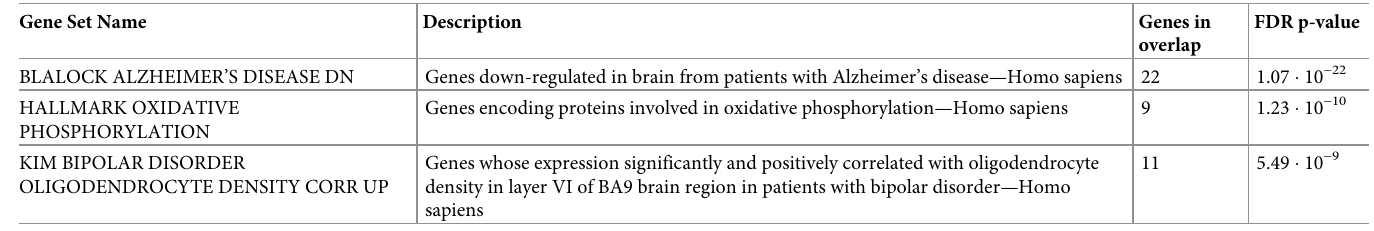
Table 3. Results of gene set enrichment analysis for C 2 community. In the third column the genes in the overlapping gene sets are reported. The fourth column indicates the false discovery rate (FDR) analog of hypergeometric p-value after correction for multiple hypothesis testing according to Benjamini and Hochberg [43]. he table shows the top three significant